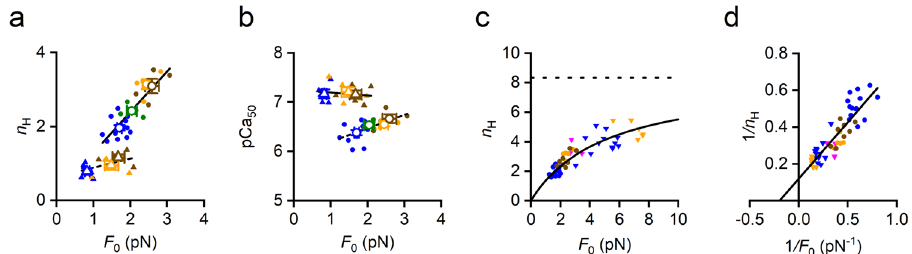
Fig. 4 Dependence of n H and pCa 50 on F 0 . a n H − F 0 relations for the soleus fi bres in control (circles) and in the presence of 1 μ M OM (triangles). Filled symbols, pooled data from twenty-three fi bres; open symbols, mean values (±SEM) at each temperature. Different colours refer to different temperatures: 12 °C, blue; 17 °C, green; 25 °C, orange; 35 °C, brown. Lines are fi rst order regression equations fi tted to pooled data (continuous, control; dashed, OM). The slope and the ordinate intercept of the regressions are: control, 1.10 ± 0.15 pN -1 and 0.19 ± 0.32 respectively; 1 μ M OM, 0.25 ± 0.13 pN -1 and 0.65 ± 0.18 respectively. b pCa 50 − F 0 relations in the soleus fi bre in control (circles) and in the presence of 1 μ M OM (triangles) from the same force-pCa relations as in a. Lines are the fi rst order regression equations fi tted to pooled data (continuous, control; dashed, OM). The slope and the ordinate intercept of the regressions are: control, 0.28 ± 0.07 pN -1 and 5.92 ± 0.14 respectively; 1 μ M OM, − 0.06 ± 0.11 pN -1 and 7.26 ± 0.15 respectively. c Superimposed n H – F 0 relations in control from the soleus fi bres (circles from a ) and from psoas fi bres (reverse triangles, pooled from ref. 33 and new data for a total of twelve fi bres). Different colours of reverse triangles refer to different temperatures: 6 °C, magenta; 12 °C, blue; 25 °C, orange. The continuous line is calculated from the linear fi t of the relation of reciprocal of pooled n H − F 0 data (continuous line in d ), the horizontal dashed line is drawn starting from the ordinate that is the reciprocal of the ordinate intercept in d . d Same data as in c plotted as reciprocals. The line is the fi rst order regression equation fi tted to the pooled data (slope, 0.61 ± 0.05 pN; ordinate intercept, 0.12 ± 0.02; abscissa intercept -0.20 ± 0.04 pN -1